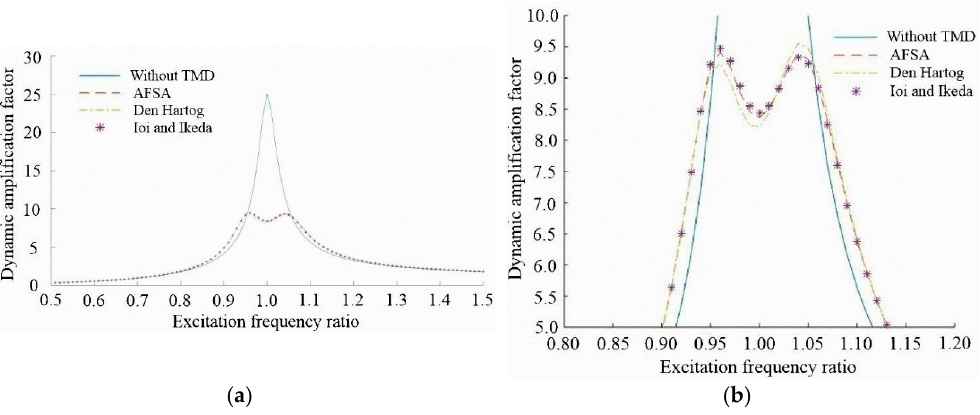
Figure 5. The comparisons of structural dynamic amplification factors under different frequency harmonic excitations. ( a ) Excitation frequency ratio from 0.5 to 1.5; ( b ) Local amplification figure.